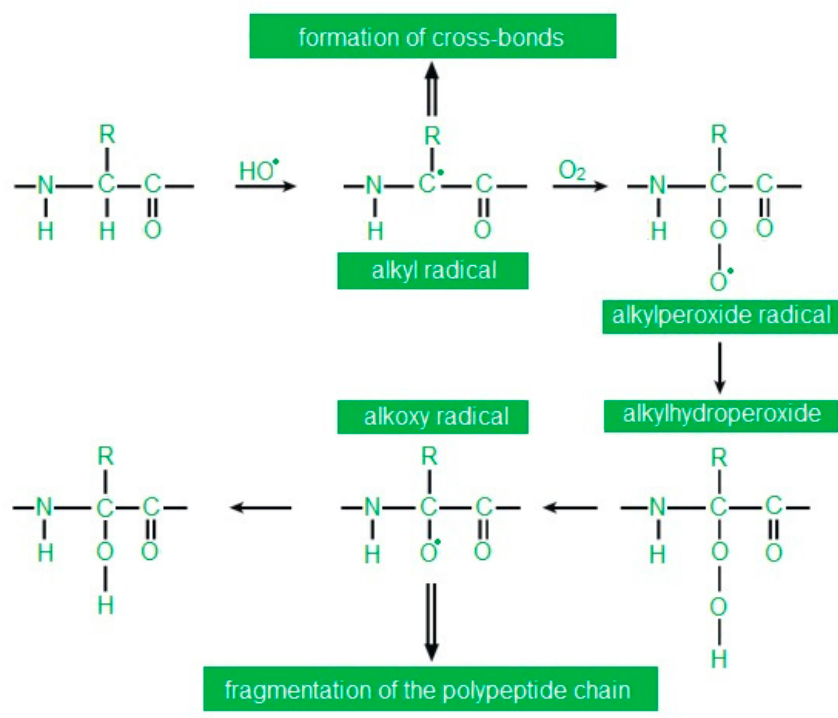
Figure 3. Abbreviation: R—rest of the fatty acid. Oxidation of the polypeptide chain at the α -carbon according to [38] as modified by the authors.